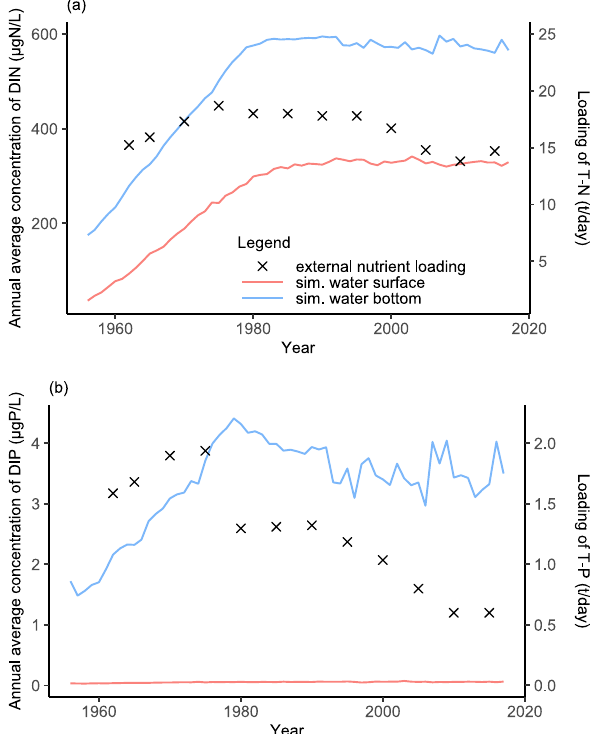
Figure 3. The fluctuation of lake nutrient concentrations at the surface (red lines) and bottom (blue lines) and external nutrient loadings (points): ( a ) nitrogen and ( b )